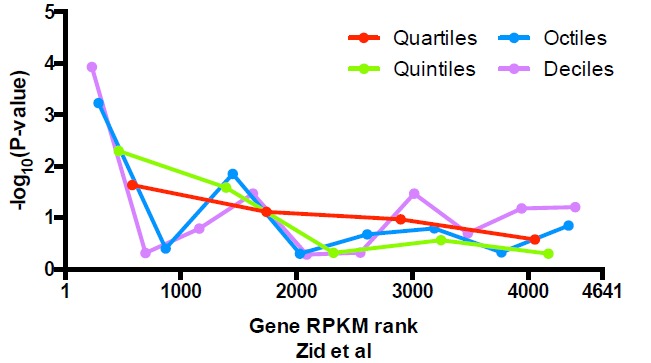
Significance of the enrichment in uniquely positioned nucleosomes among genes stratified by expression level determined in Zid et al.